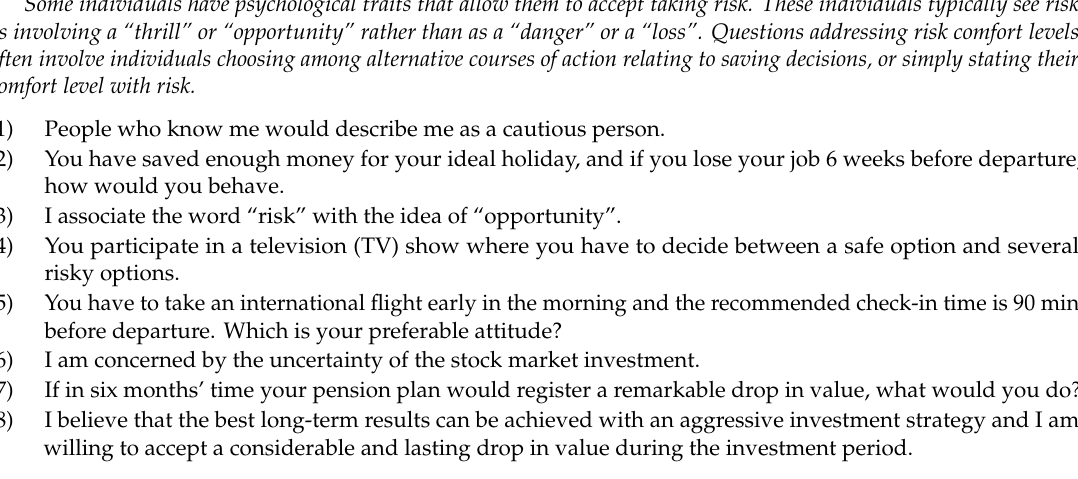
Box 1. Risk profiling construct of